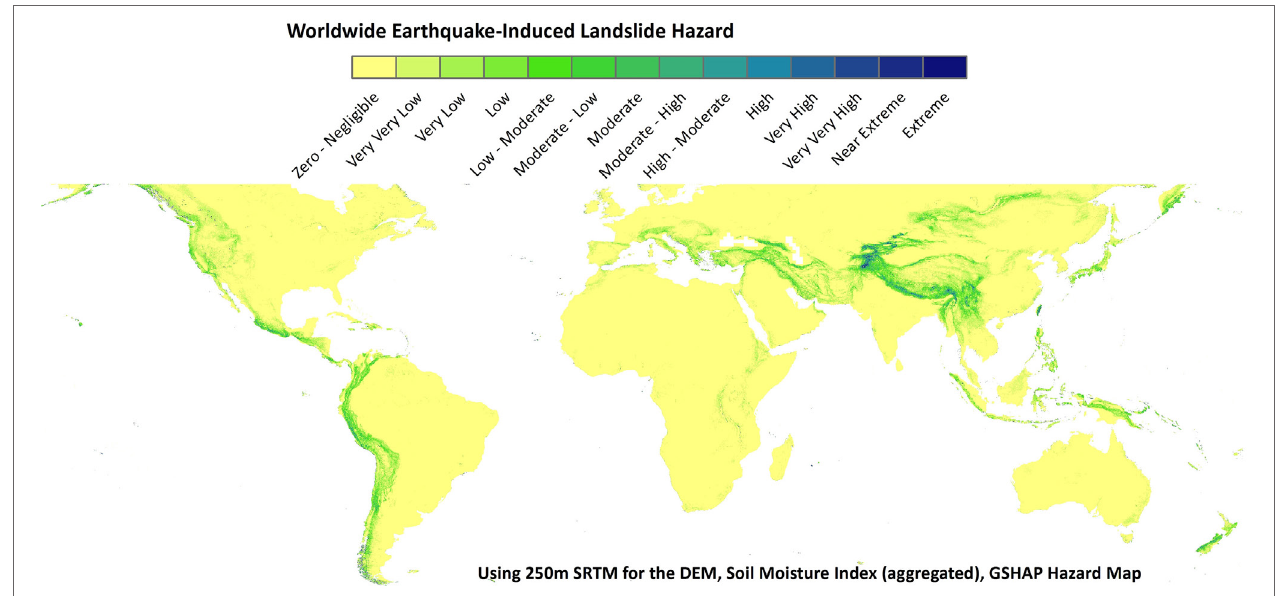
FigUre 1 | Worldwide landslide hazard analysis based on the model produced in this study .